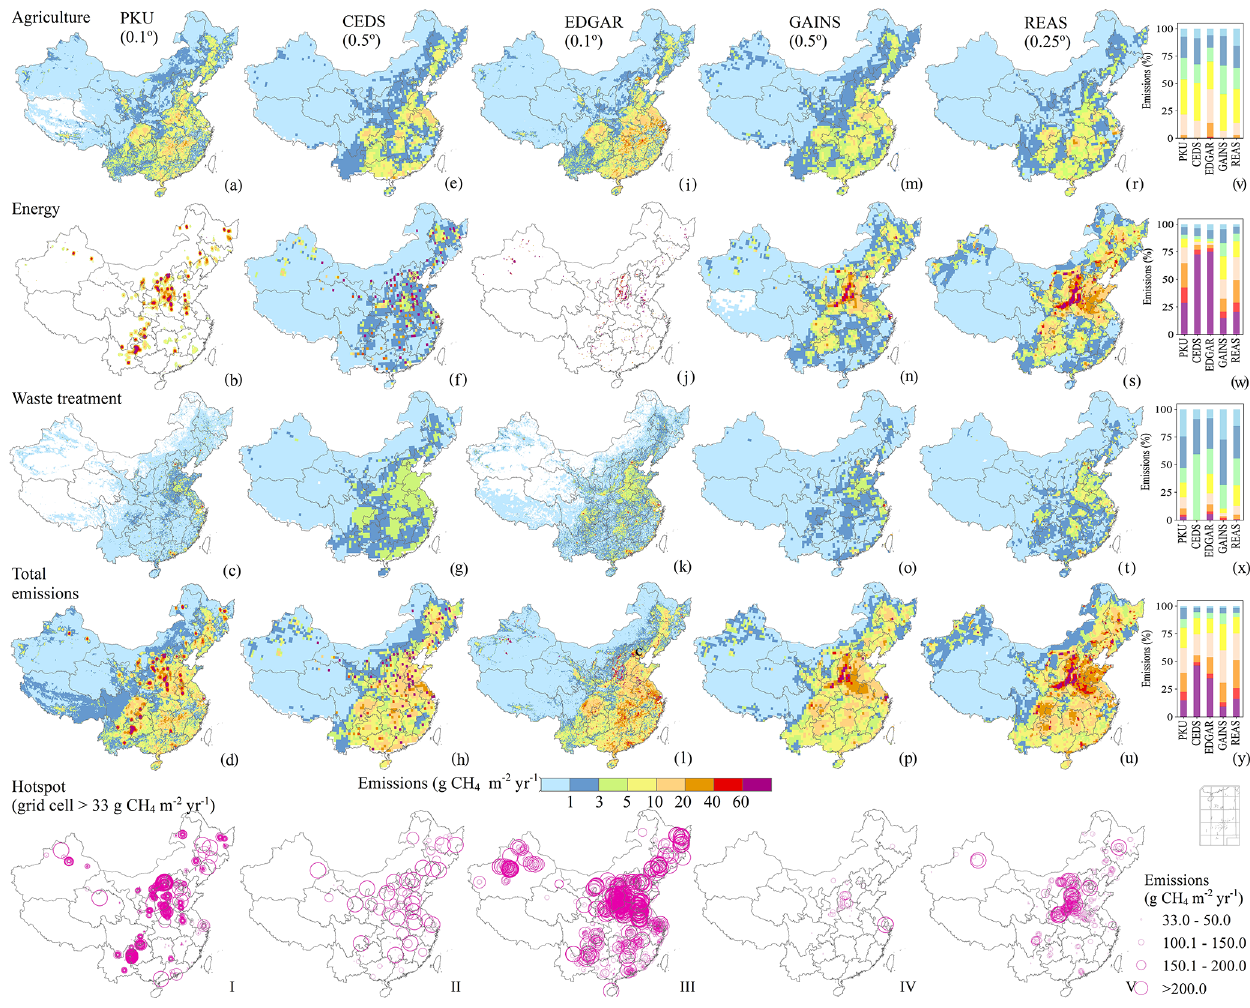
Figure 2. The spatial distribution of sectoral and total anthropogenic CH 4 emissions from PKU (a–d) , CEDSv2017-05-18 (e–h) , EDGAR v5.0 (i–l) , GAINS (m–p) in 2010, and REAS (q–t) in 2008 and emissions frequency (u–x) . The top 2% high-emitting grids (emissions > 33gCH 4 m − 2 yr − 1 ) were based on